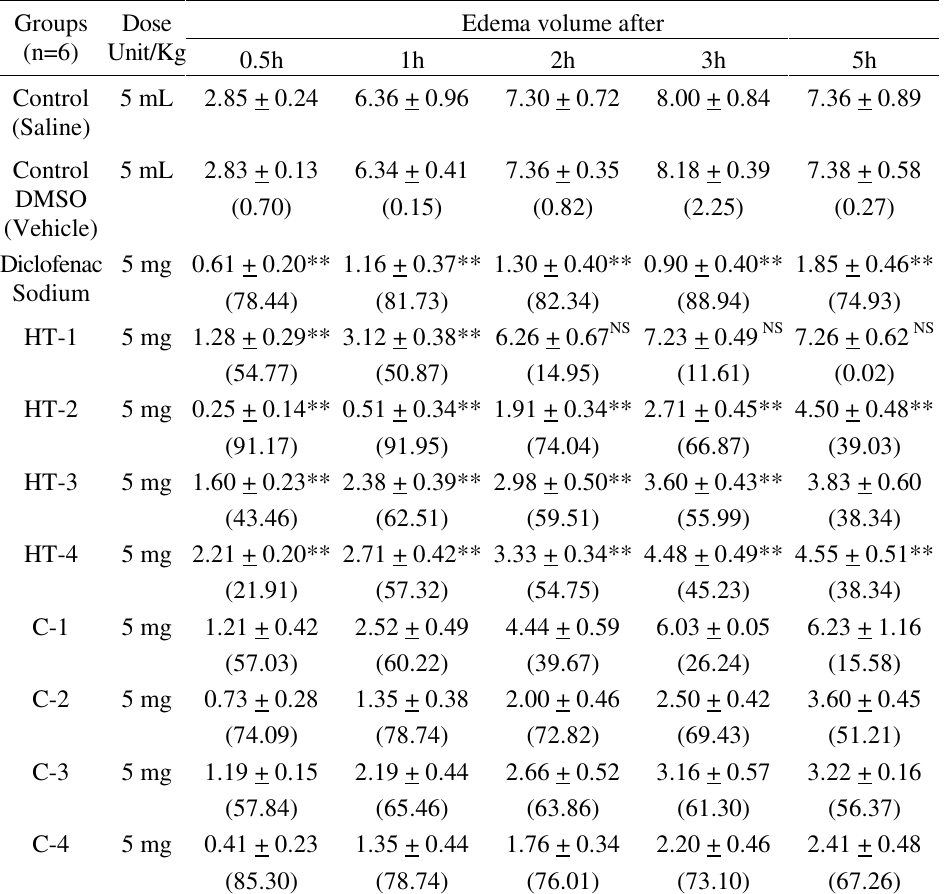
Table 2. Effect of hydroxytriazenes and their vanadium complexes on carrageenan induced rat paw edema